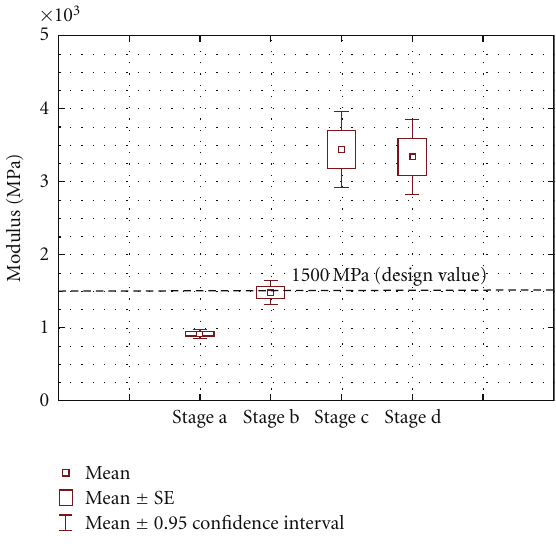
Figure 13: Moduli of foamed asphalt-treated layer at each stage.